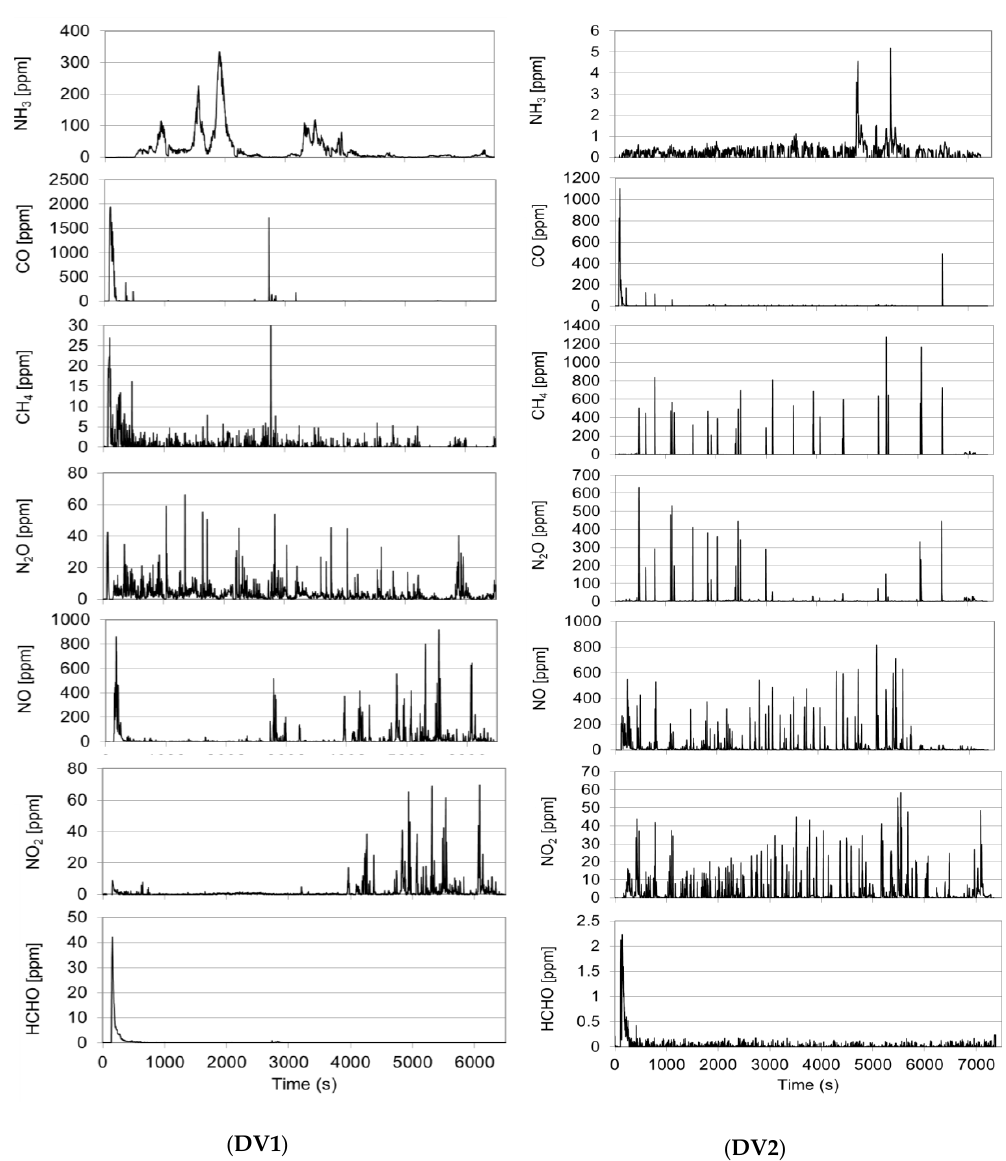
Figure 4. NH 3 , N 2 O, NO, NO 2 , CO, CH 4 , and HCHO on-road emissions profiles registered during the RDE test on route 1 for the DV1 (left panels) and for the DV2 (right panels). The emissions of N 2 O ranged from 19 mg N 2 O/km (Route-2-dynamic) to 27 mg N 2 O/km (Route- 1) throughout the entire tests. These emissions were 3 to 4 times higher than the current USA limit (6.3 mg/km over the FTP) and 1.5 times higher than the China 6 standard (20 mg/km over the WLTC). These on-road emission factors measured on the RDE-compliant route (Route-1) were higher than